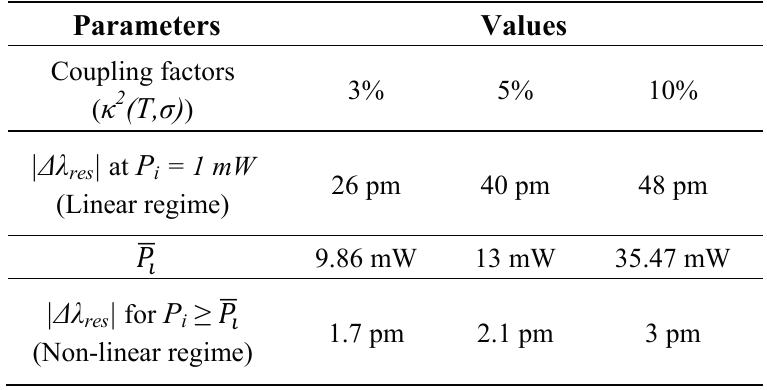
Table 3. Sensor resolution (detection of